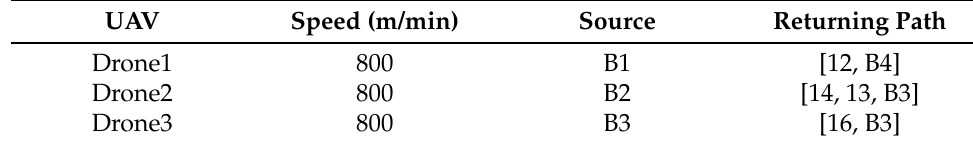
Table 5. Data delivery when UAVs may be late for no more than 30 min.